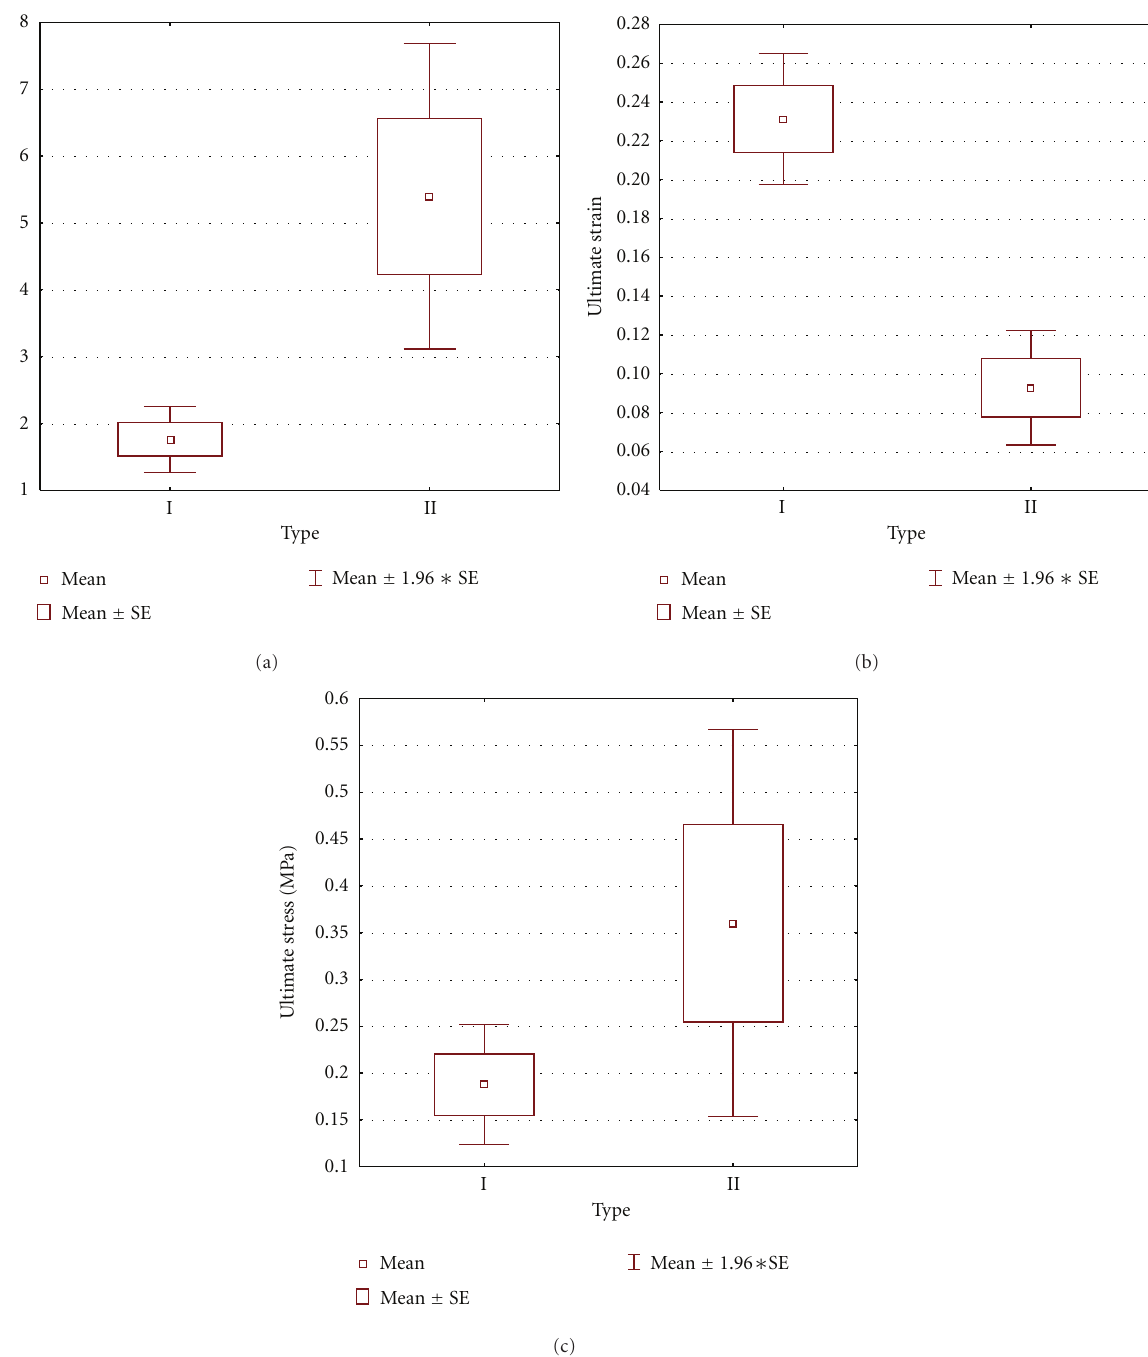
Figure 4: The moduli of elasticity, the ultimate strain, and ultimate stress of the group of pure PCL/PVA composite (type I) and the group of the PCL/PVA composite covered by HA layer (type II). There is a significant di ff erence in the moduli of elasticity between these groups (determined by t -test; P = 0 . 04) (a) and also in the ultimate strain ( P < 0 . 001) (b), but not in the ultimate stress ( P = 0 . 26) (c). Mean is the mean value, SE is the standard